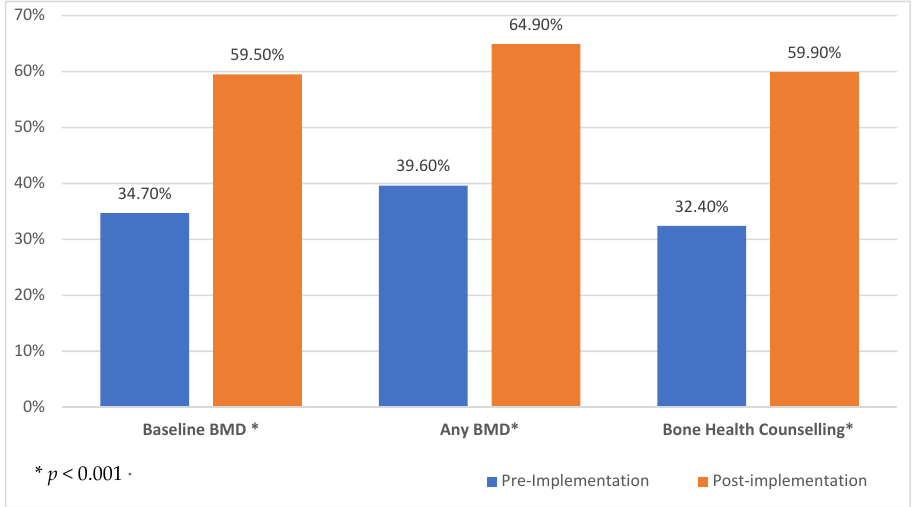
Figure 3. Baseline Bone Mineral Density (BMD) Test.